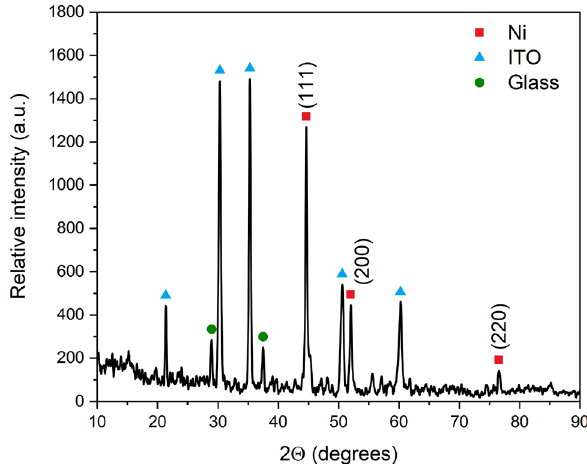
Figure 3. XRD spectrum of Ni nanocavity deposited on ITO glass slide.